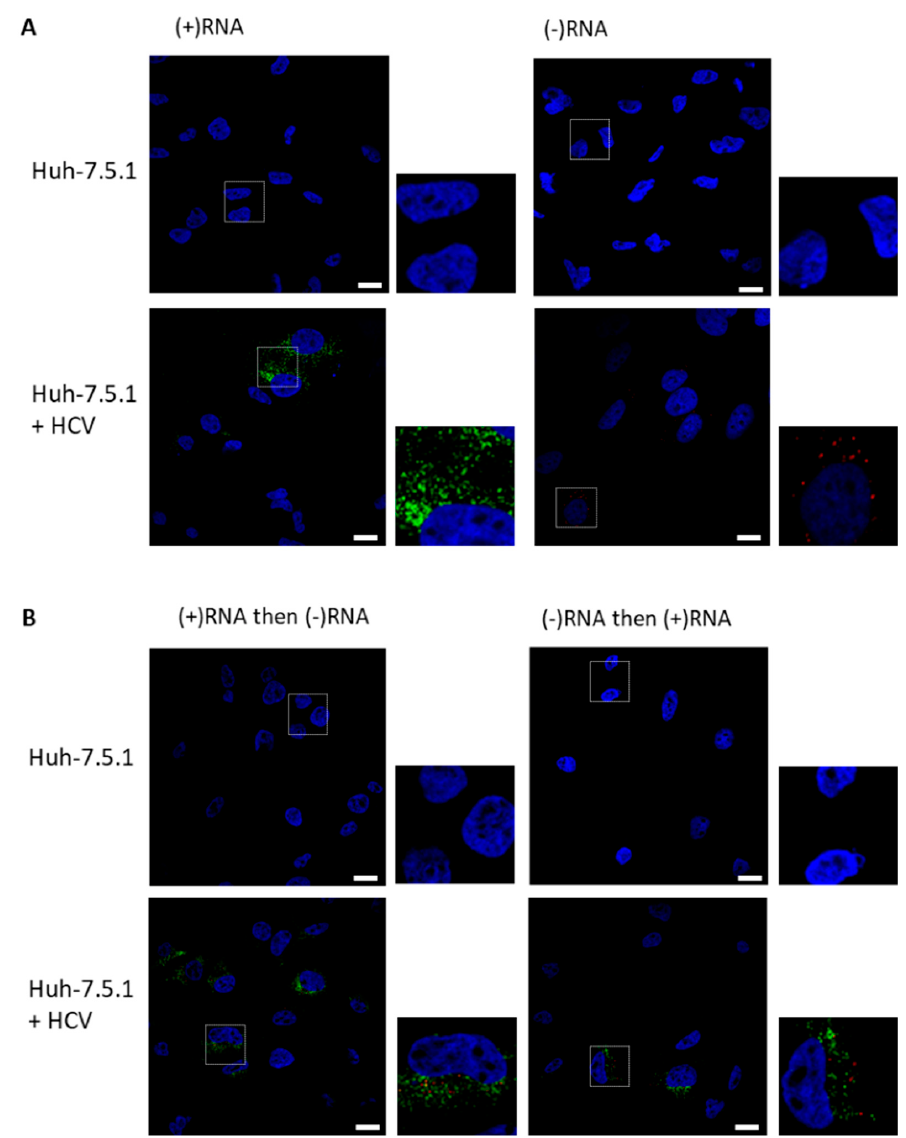
Figure 2. Strand-specific bDNA FISH in HCV. Huh-7.5.1 cells or Huh-7.5.1 cells infected with HCV Jc1/Gluc2A were fixed and probed for ( − )RNA (red) and (+)RNA (green), and nuclei were stained with 4 ′ ,6-diamidino-2-phenylindole (DAPI, blue). Cells were imaged on a Nikon C2 confocal microscope using a 60× oil-immersion objective. ( A ) Representative images are shown for (+)RNA or ( − )RNA singly stained cells. ( B ) Representative images are shown for cells stained first for (+)RNA, then for ( − )RNA or cells were stained first for ( − )RNA, then for (+)RNA. Boxed regions shown enlarged. Scale bars represent 10 µm.